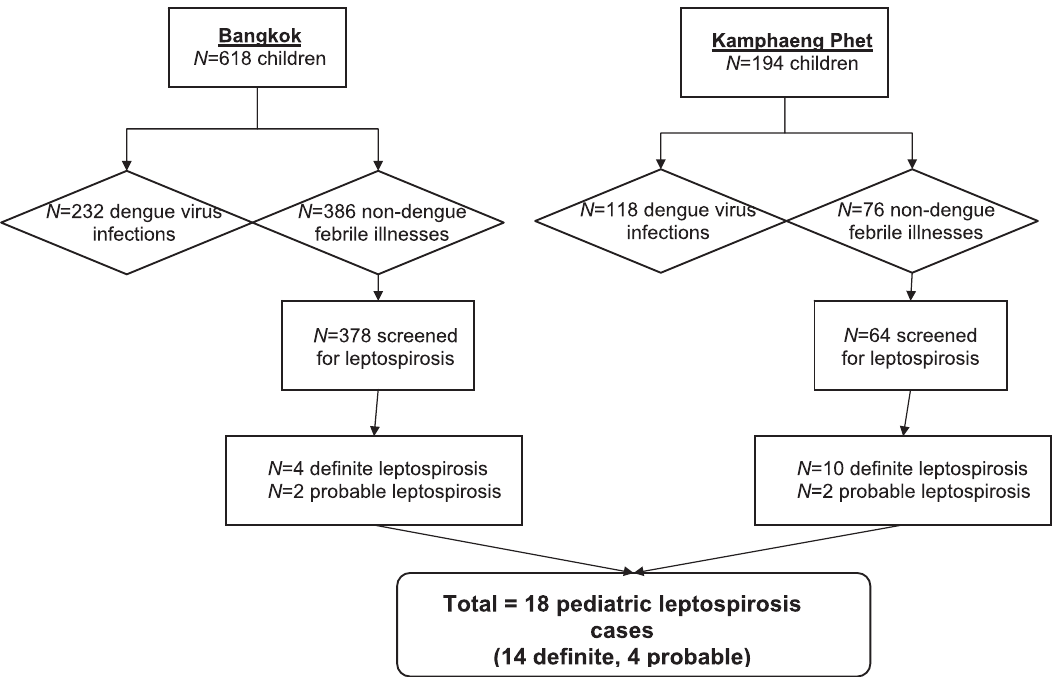
Figure 1. Schematic flow diagram of study subject categorization and leptospirosis testing.